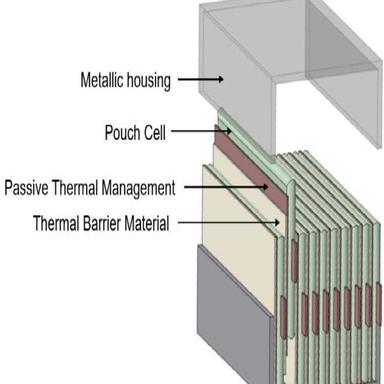
Schematics of the battery pack with thermal barrier.